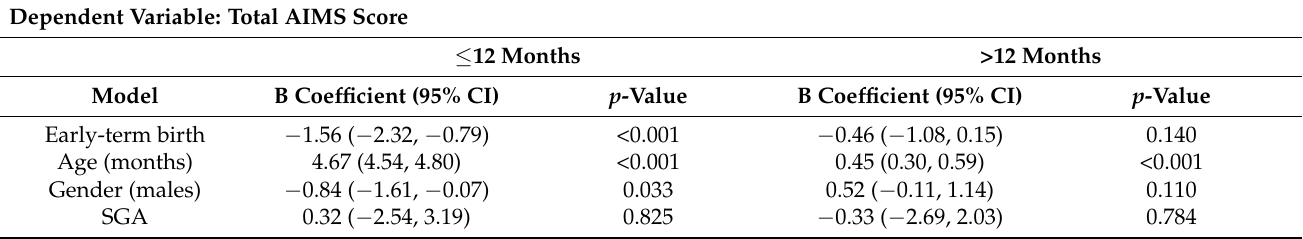
Table 3. Multivariate regression analyses for total AIMS scores following stratification by